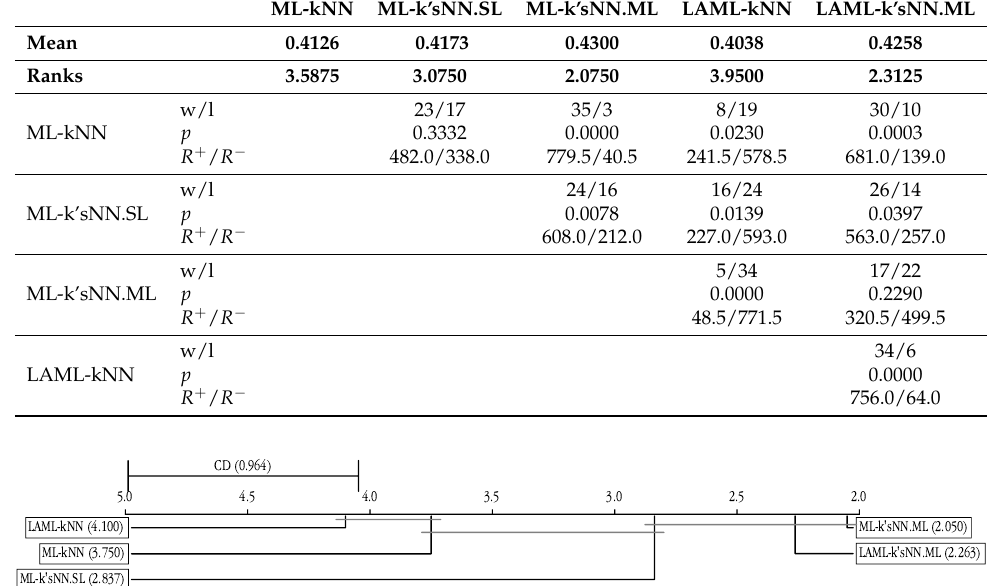
Table 5. Comparison of the different methods using F1 micro metric.